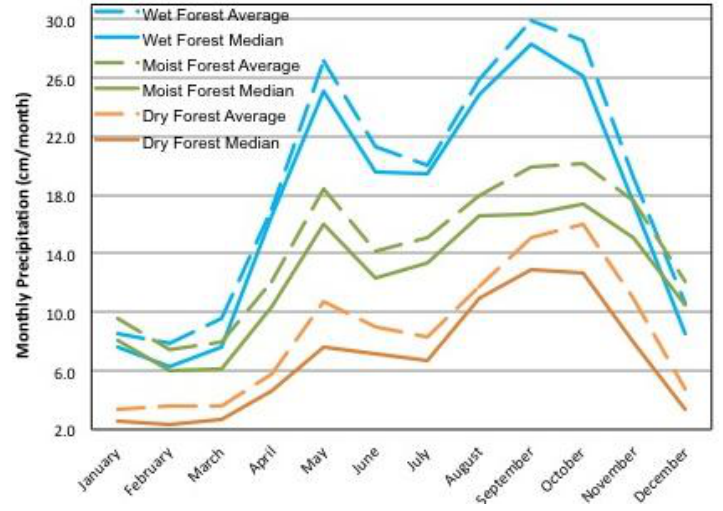
Figure 2. Average and Median Precipitation by Month for Puerto Rico’s HELZ,